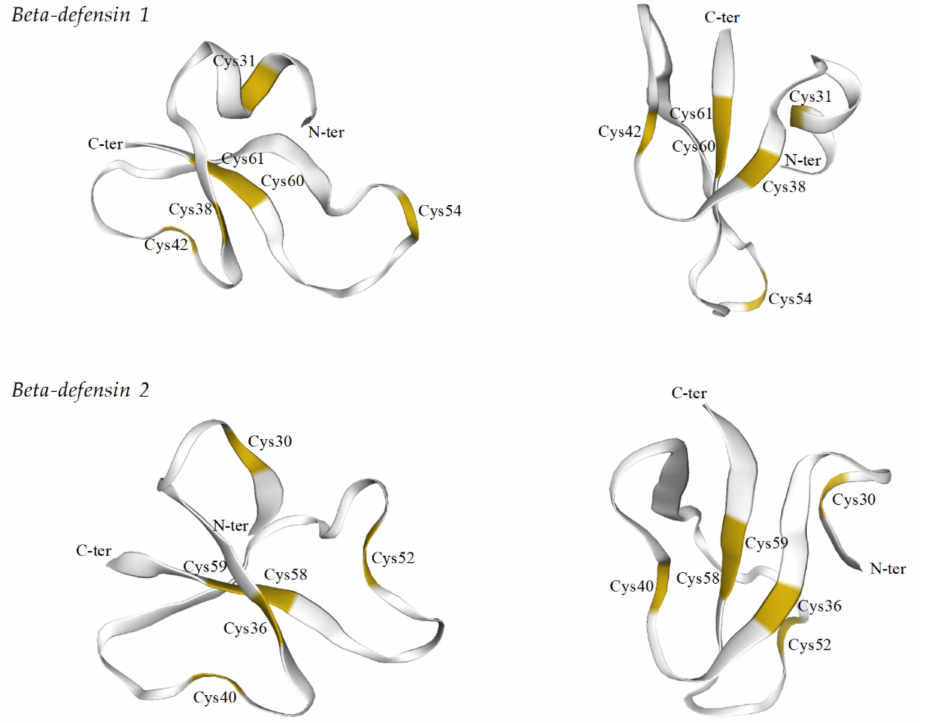
Figure 3. Three dimensional models of sea bass beta-defensins 1 and 2. Conserved cysteines are highlighted. Beta-defensin 1 shows an additional alpha-helix at the N-terminal. Models were predicted using as templates human beta-defensin 6 (2lwl.1.A) for beta-defensin 1, and human beta-defensin 4 (5ki9.1.A) and oyster big defensin (6qbk.1.A) for beta-defensin